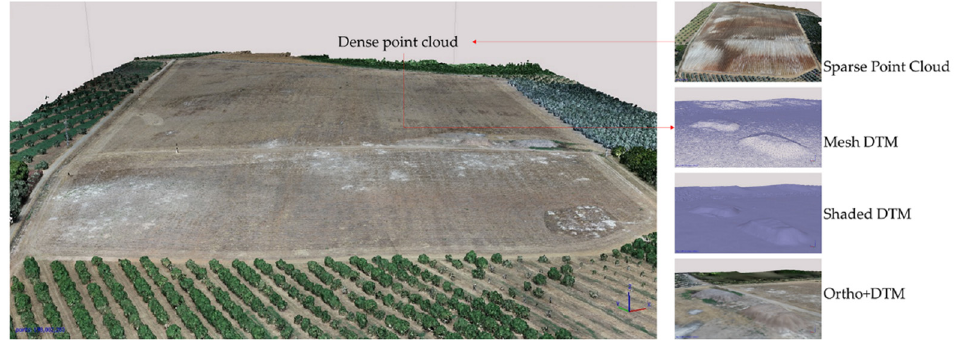
Figure 10. 3D models obtained from the June image block processing: dense point cloud, sparse point cloud, DTM as a triangular mesh and shaded relief, and orthoimage over DTM.